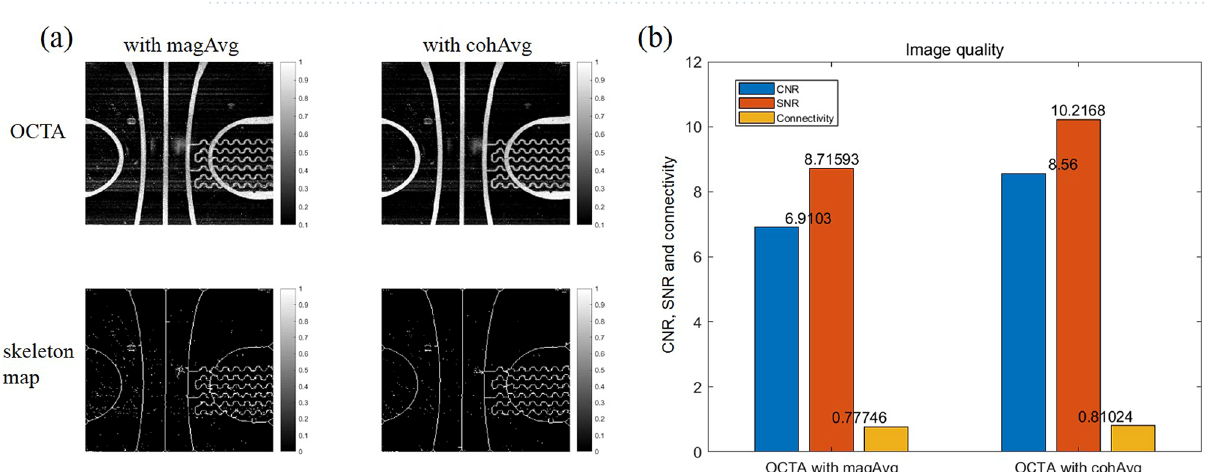
Figure 4. Comparison of OCTA images for retina phantom obtained by magnitude averaging (magAvg) or coherent averaging (cohAvg). ( a ) OCTA image applying magAvg. ( b ) OCTA image applying cohAvg. ( c , d ) Profiles of lines number 1 and 2 drawn in the averaged OCTA images, respectively. BG, background region. TR tissue region, FR flow region.